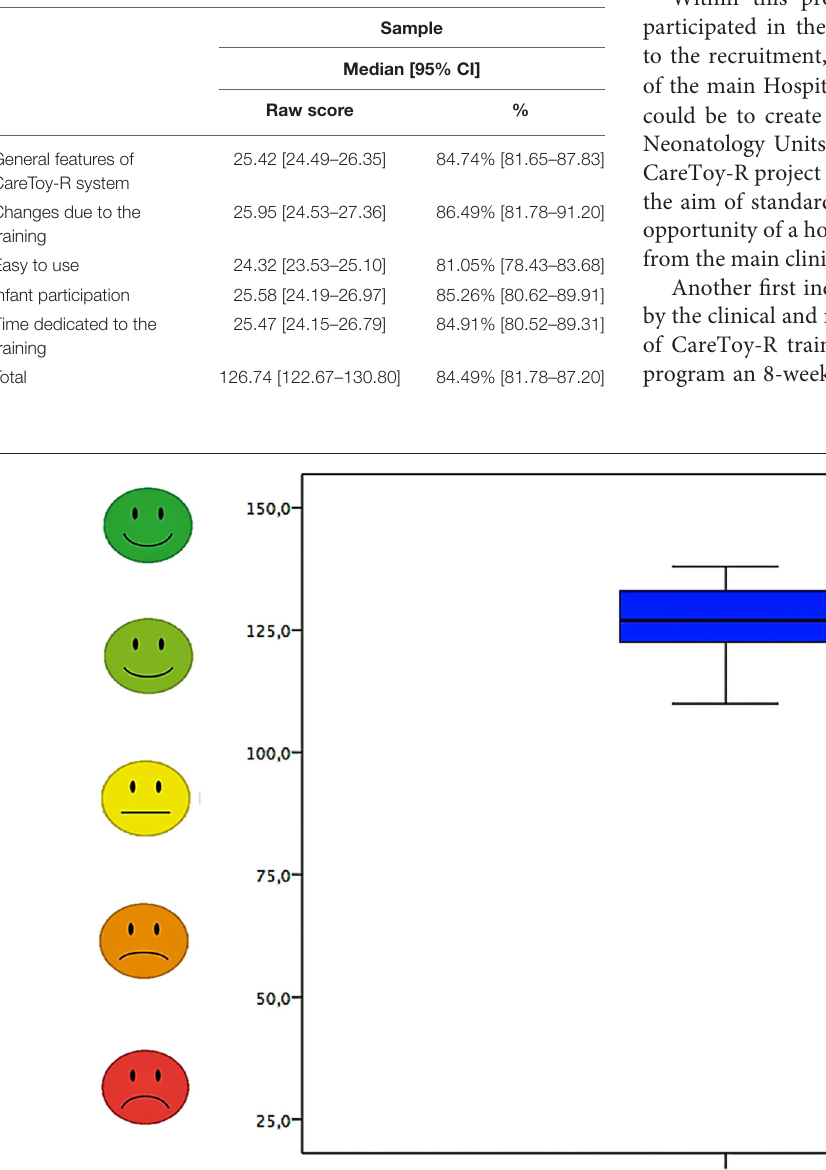
TABLE 6 | Results of CRQPE questionnaire.